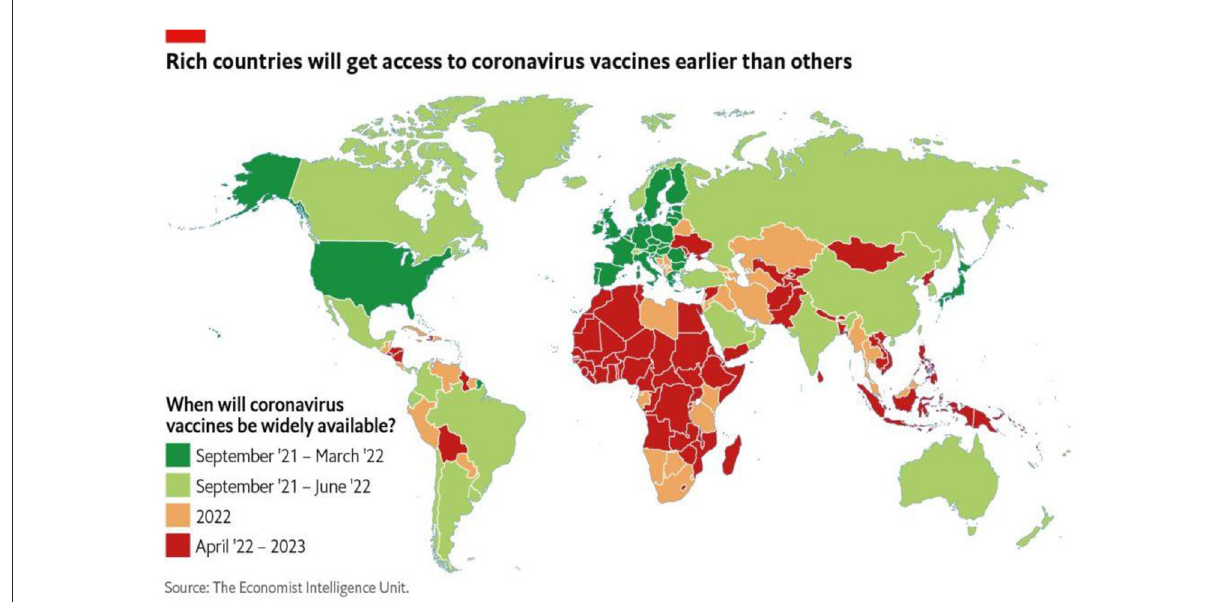
FIGURE1 When will coronavirus vaccines be widely available? Source: The Economist Intelligence Unit.